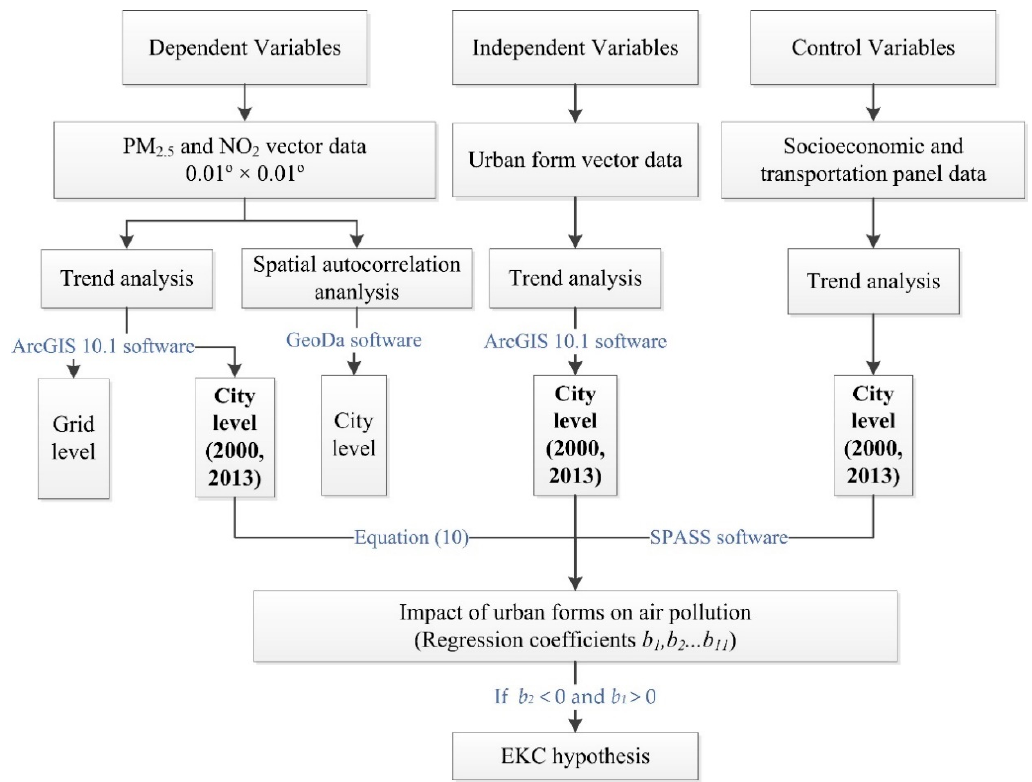
Figure 2. Technical flow chart of this study.